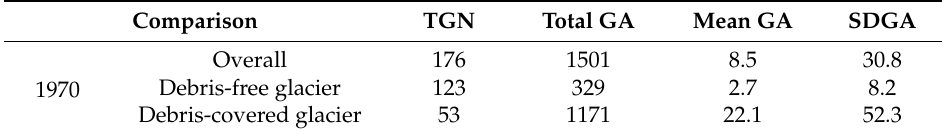
Figure 10. Glacier area change rate during 1970–1980 ( a ), 1980–1990 ( b ), 1990–2000 ( c ) and 2000–2014 ( d ) periods (( − ): decreased in area, ( + ): increased in area). Table 5. Comparison of glacier inventories from this study (glacier area: km 2 ).